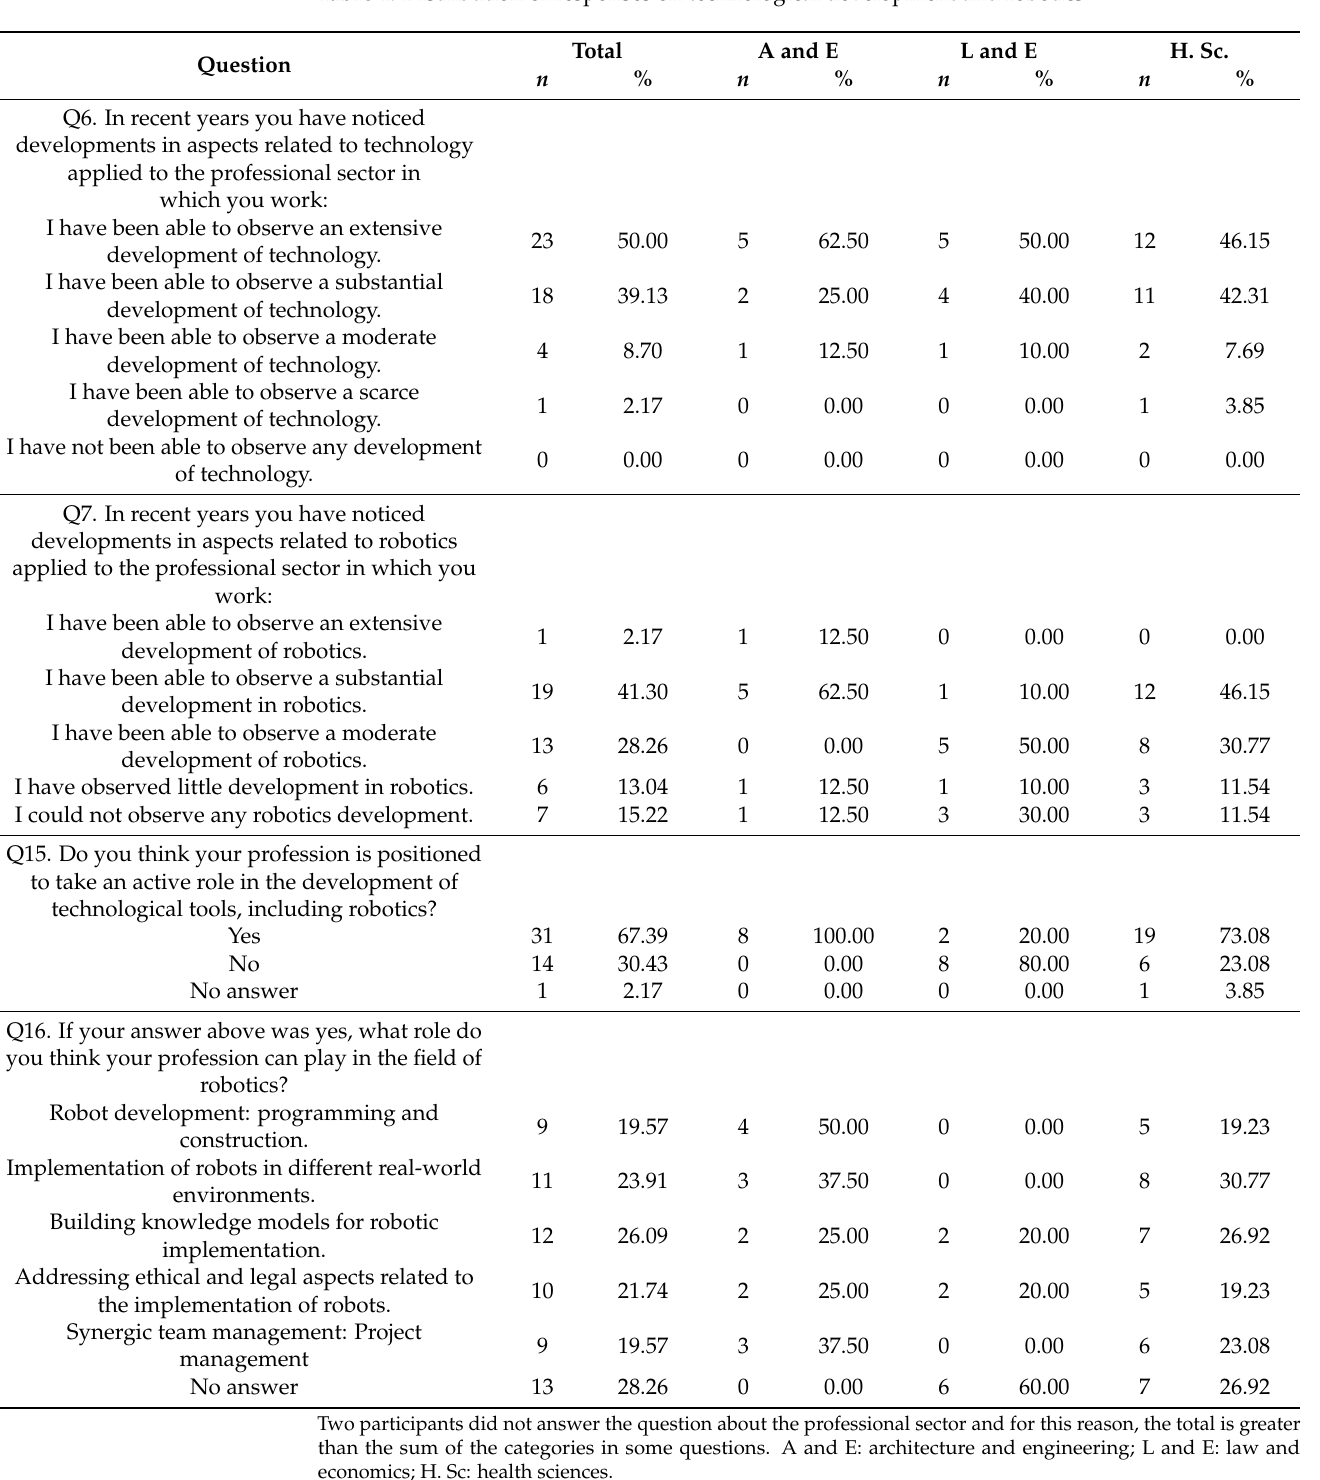
Table 4. Distribution of responses on technological development and